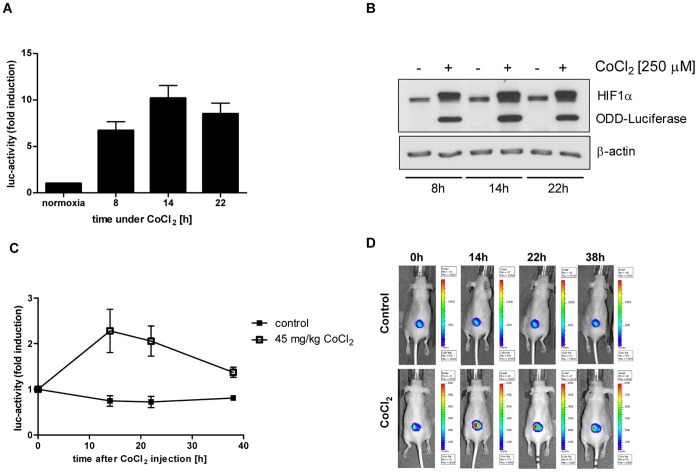
CoCl2 increases luciferase activity in A549 ODD-Luc cells in vitro and in vivo.(A,B) Luciferase-activity (A) and HIF-1α, and protein levels of ODD-luciferase (B) of CoCl2 (0.25 mM)-treated, stably transfected ODD-Luc A549 cells, determined at the indicated time points. Error bars represent mean ±SE. (C) Luciferase activity of A549 ODD-Luc-derived tumor xenografts in mice injected with CoCl2 (45 mg/kg) at time point 0 hour and at the indicated time points thereafter. (nCoCl2 = 6; ncontrol = 4) Error bars represent mean ±SE. (D) Representative in
vivo bioimages of untreated and CoCl2-treated mice.